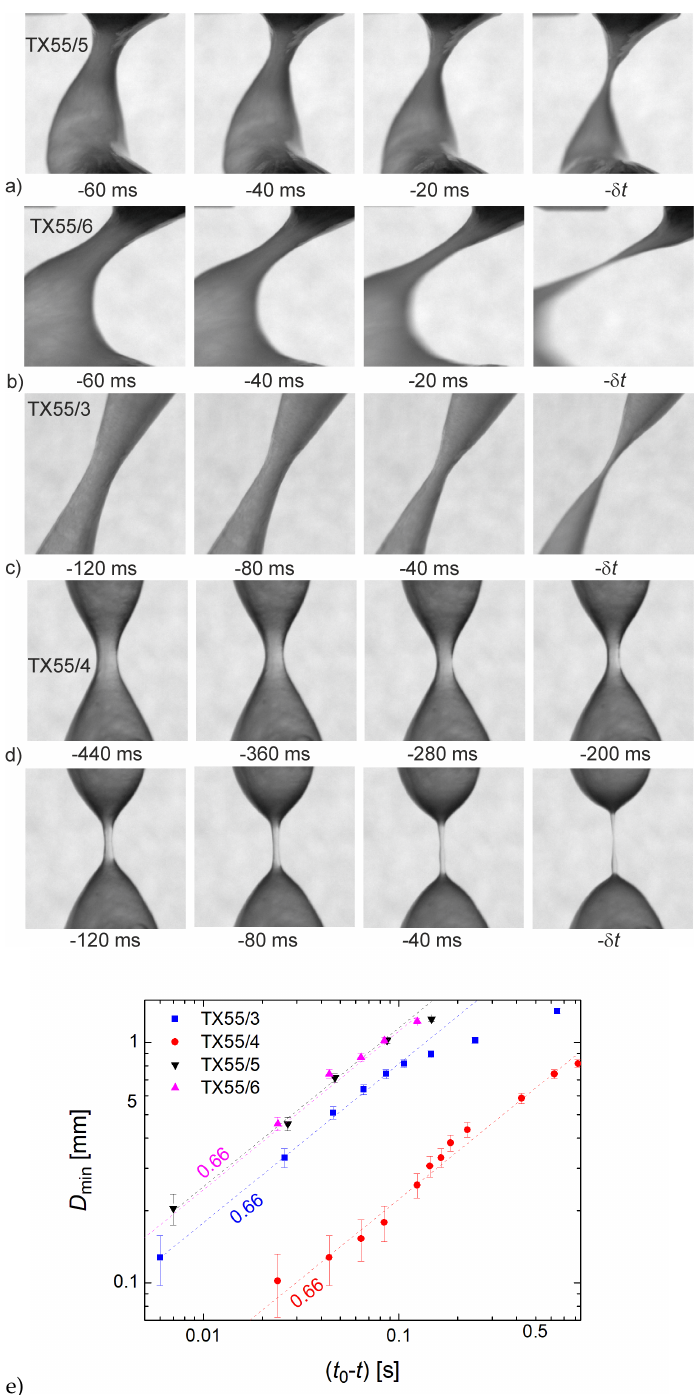
Figure 12. Some smectic bridges during breakup: ( a ) ST00554 column of L = 6.0 mm in SmC; ( b ) ST00552 column of 6.0 mm in SmA; ( c ) ST00554 column of 18 mm in SmC. These three columns were broken up by sideways acceleration during the re-entry of the rocket. ( d ) The pinch-off of an ST00552 column in SmA under zero gravity conditions without acceleration (two rows). The time scale of the rupture was much longer, yet the same power law was found. Image sizes were 5 mm × 5 mm. The time δ t of the last image in each series was within 20 ms before the pinch- off. ( e ) A summary of the thinning dynamics of the four experiments. The dashed lines indicate D min ∝ ( t 0 − t ) 0.66